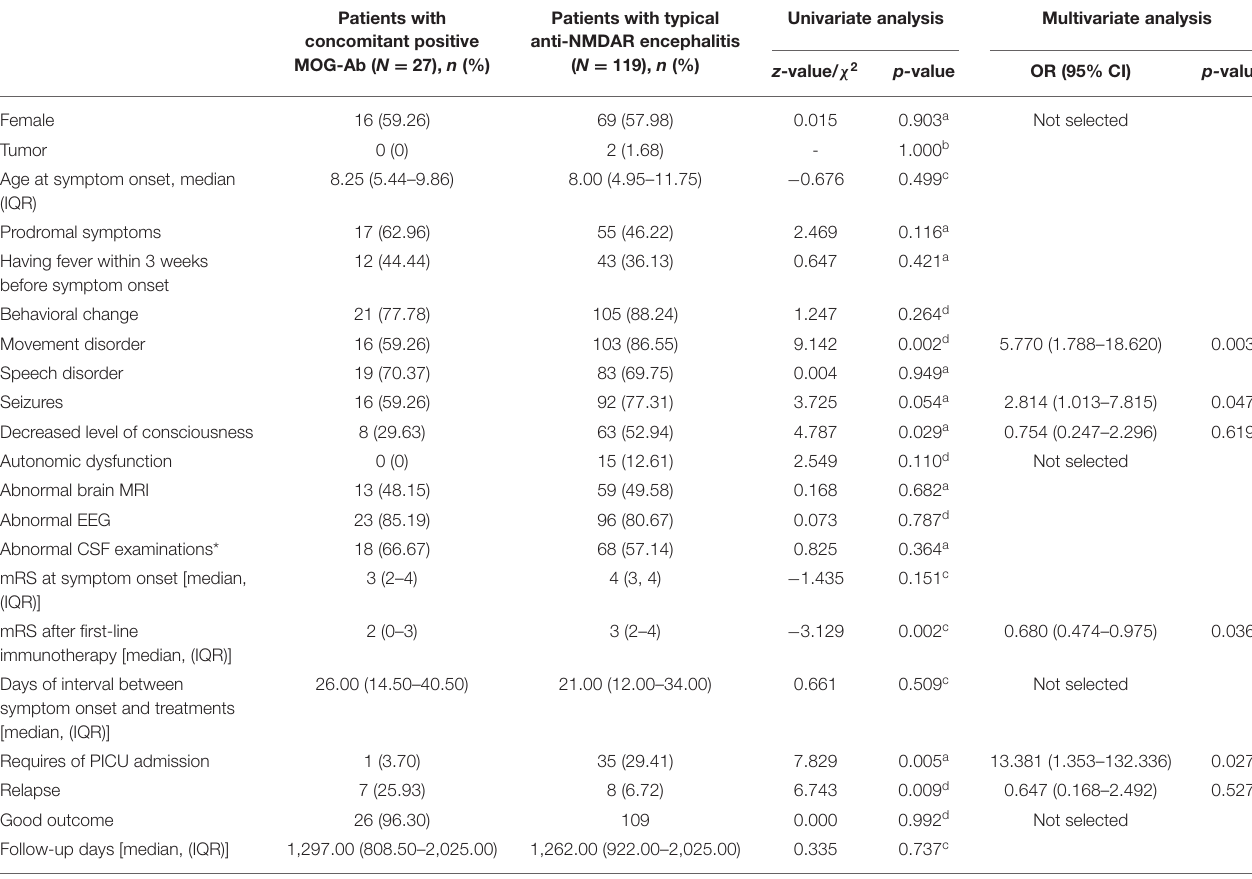
TABLE 1 | Comparison of clinical characteristics between patients with concomitant positive MOG-Ab and patients with typical anti-NMDAR encephalitis. Patients with Patients with typical Univariate analysis Multivariate concomitant positive anti-NMDAR encephalitis MOG-Ab ( N = 27), n (%) ( N = 119), n (%)